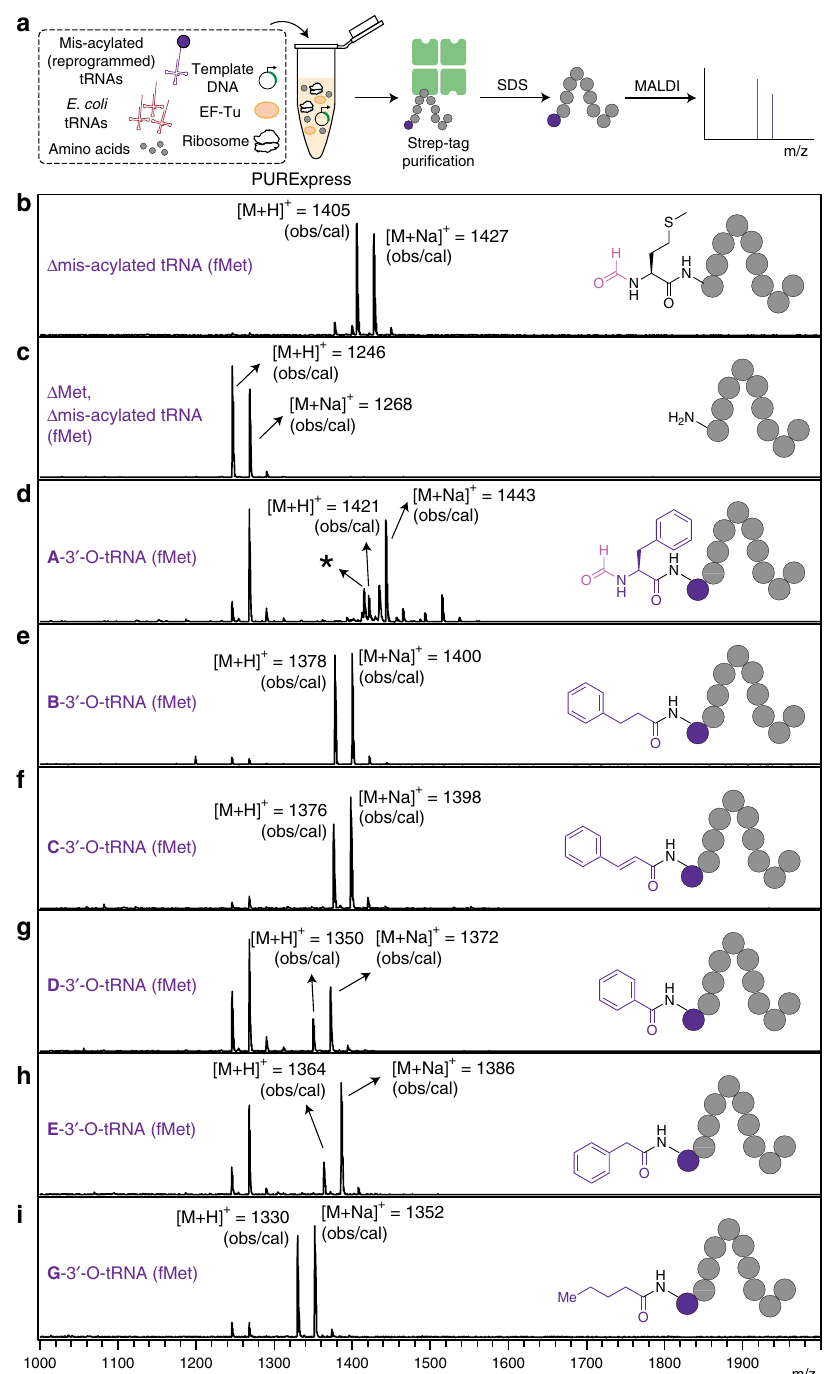
Fig. 5 Ribosomal synthesis of N-terminal functionalized peptides with noncanonical substrates. a Schematic overview of peptide synthesis and characterization. N-terminal functionalized peptides were prepared in the PURExpress system by using Fx-charged tRNA fMet , puri fi ed via the Strep tag, denatured with SDS, and characterized by MALDI mass spectrometry. b Mass spectrum of the peptide in the presence of all 20 natural amino acids and absence of Fx-charged tRNA. c Mass spectrum of the peptide in the absence of methionine and Fx-charged tRNA. d – i Mass spectra of peptides with N-terminally incorporated noncanonical substrates. * A minor amount of peptide containing phenylalanine at the N-terminus was unformylated. NH 2 - F WSHPQFEKST-OH; [M + Na] + = 1415, A : phenylalanine, B : hydrocinnamic acid, C : cinnamic acid, D : benzoic acid, E : phenylacetic acid, G : propanoic